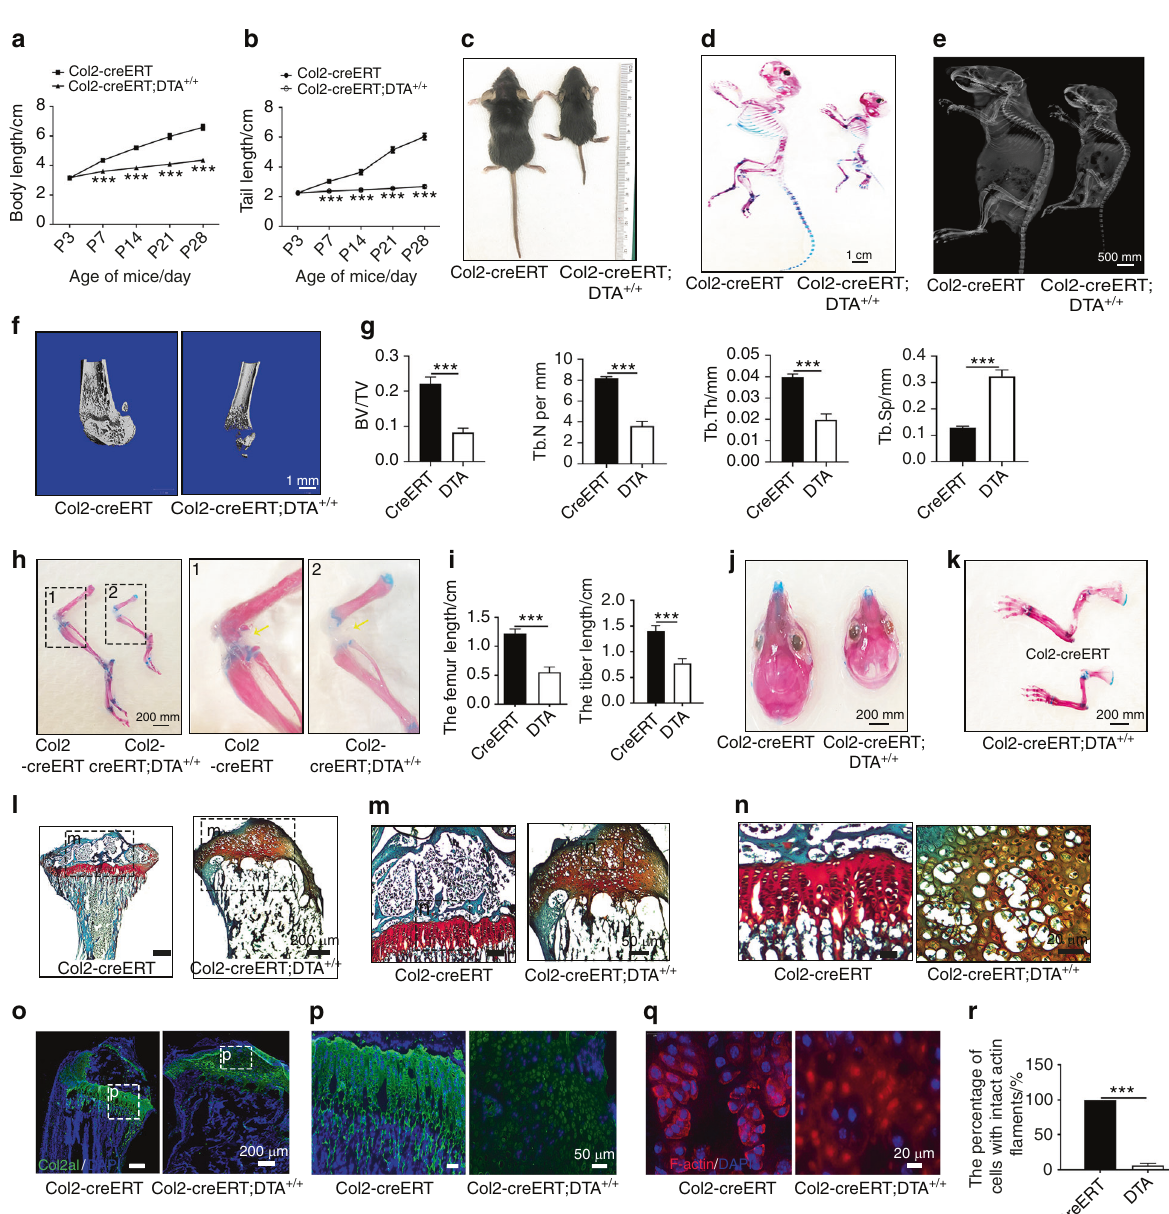
Fig. 4 Postnatal deletion of Col2 + cells causes mouse growth retardation and a type II collagenopathy phenotype. a , b Quantitative analysis of the body length and tail length of Col2-creERT and Col2-creERT;DTA + / + mice from P3 to four weeks of age ( n = 6 mice per condition; three independent experiments). The data are presented as the means ± s.ds. c Macroscopic image of 4-week-old littermates. The mutant (right) mouse is small and exhibits dwar fi sm. d Total view of Col2-creERT and Col2-creERT;DTA + / + mice double stained with Alizarin red and Alcian blue at four weeks of age. e X-ray of 4-week-old Col2-creERT and Col2-creERT;DTA + / + mice. f Representative picture of the microCT 3D structure of the femur head of 4-week-old Col2-creERT and Col2-creERT;DTA + / + mice. g Quantitative analysis of the BV/TV, Both, Tb.N, and Tb. Sp of the femurs of 4-week-old Col2-creERT (CreERT) and Col2-creERT;DTA + / + (DTA) mice ( n = 5 mice per group). The data are presented as the means ± s.ds. h Total view of the lower extremities of Col2-creERT and Col2-creERT;DTA + / + mice double stained with Alizarin red and Alcian blue at four weeks of age. Yellow arrow, delayed secondary ossi fi cation development in Col2-cre;DTA + / − mice. i Quantitative analysis of the femur length and tibia length of 4-week-old Col2-creERT (CreERT) and Col2-creERT;DTA + / + (DTA) mice ( n = 6 mice per condition; three independent experiments). The data are presented as the means ± s.ds. j Total view of the skulls of Col2-creERT and Col2-creERT;DTA + / + mice stained with Alizarin red and Alcian blue at four weeks of age. k Total view of the forelimb of Col2-creERT and Col2-creERT;DTA + / + mice stained with Alizarin red and Alcian blue at four weeks of age. l Safranin O/Fast Green staining of coronal sections of the femurs of 4-week-old Col2-creERT and Col2-creERT;DTA + / + mice. m High-magni fi cation image showing secondary ossi fi cation and cartilage in the femurs of 4-week- old Col2-creERT and Col2-creERT;DTA + / + mice. n High-magni fi cation picture showing the chondrocyte morphology of 4-week-old Col2-creERT and Col2-creERT;DTA + / + mice. o Immuno fl uorescence staining of the GP and AC of 4-week-old Col2-creERT and Col2-creERT;DTA + / + mice for type 2 collagen. p High-magni fi cation image showing type 2 collagen staining in 4-week-old Col2-creERT and Col2-creERT;DTA + / + mice. q Phalloidin staining showing the cartilage cytoskeleton of 4-week-old Col2-creERT and Col2-creERT;DTA + / + mice. r Quantitative measurements of the percentage of cells with intact actin fragments relative to the total cells in Col2-creERT (CreERT) and Col2-creERT; DTA + / + (DTA) mice ( n = 6 mice per condition; three independent experiments). The data are presented as the means ± s.ds. The statistical signi fi cance was determined by one-way ANOVA and Student ’ s t test. * P < 0.05, ** P < 0.01, *** P < 0.000 1, NS not statistically signi fi